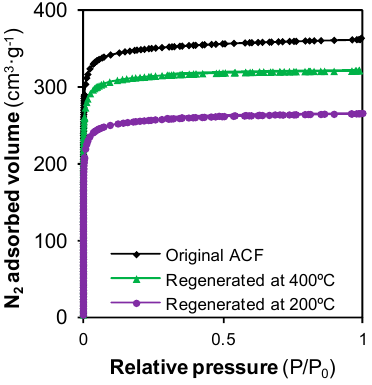
Figure 5. N 2 adsorption-desorption isotherms for the original ACF and the ACFs regenerated at 200 °C and 400 °C.